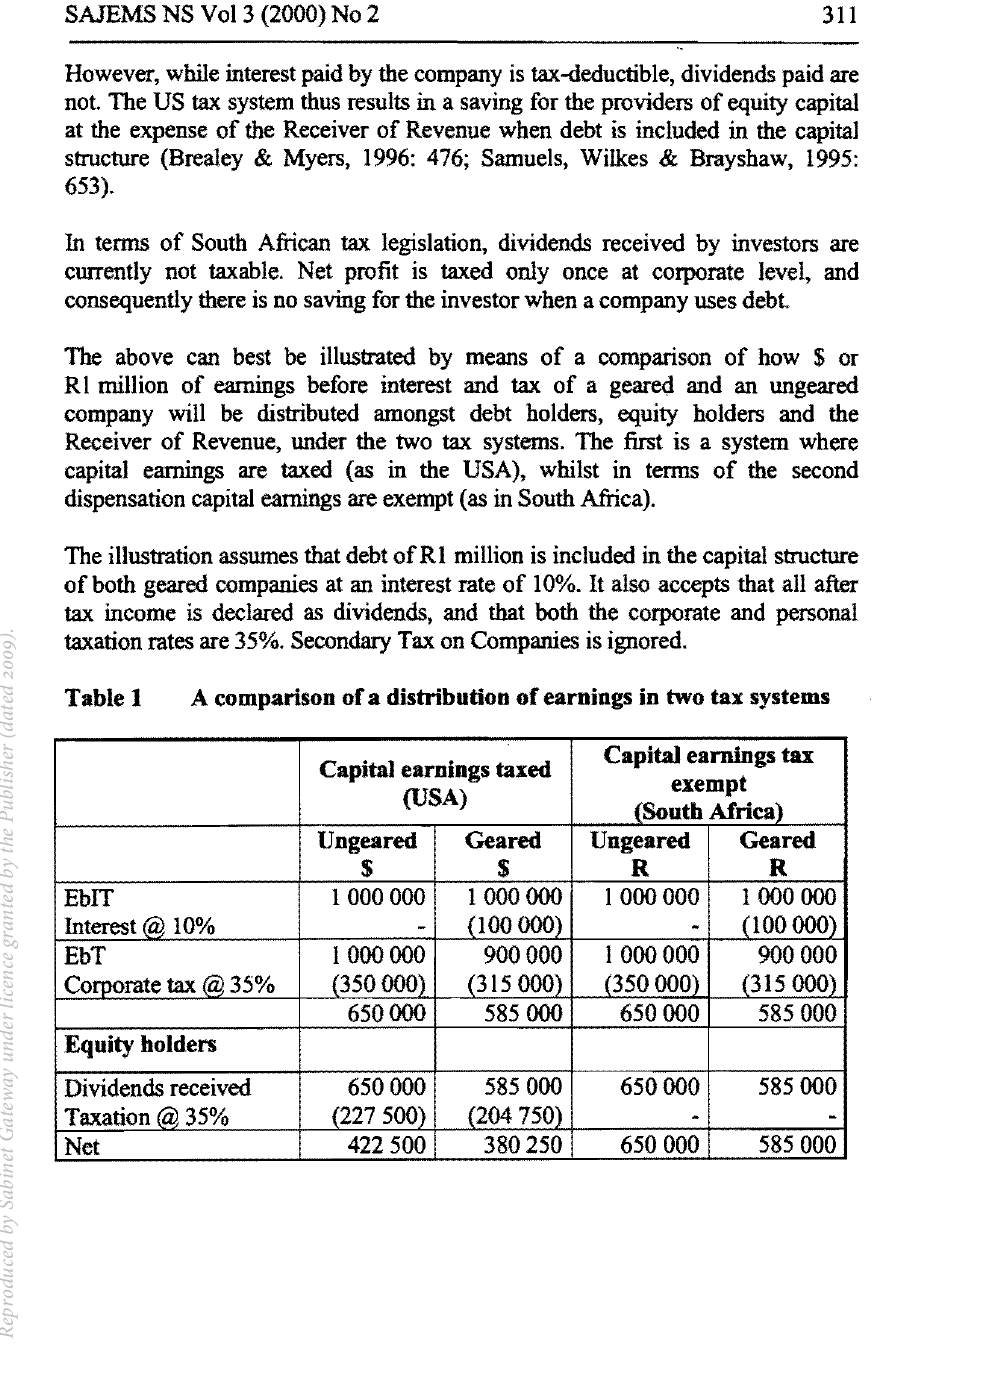
Capjtal earnings tax exempt (Soutb Mriea)